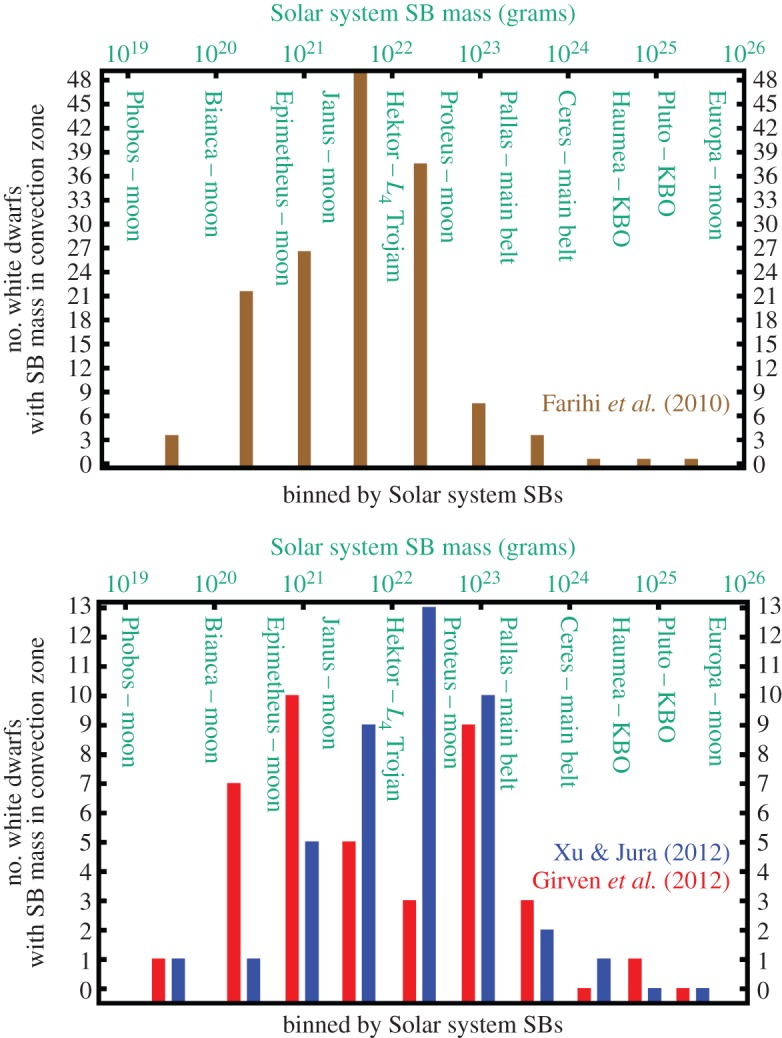
Histograms of the accumulated mass of rocky substellar bodies that were accreted onto white dwarfs during the last Myr or so, including both detections and limiting values. Differently coloured bars refer to three different WD samples (brown: data from [93] assuming that Ca represents 1.6% of the mass of the accreted bodies, similar to the corresponding mass fraction of the bulk Earth—see table 3 of [102]; blue: data displayed in fig. 12 of [103]; red: data displayed in fig. 9 of [104]). The panels are separated according to sample size (see y-axis). For observational subtleties associated with the data, see the corresponding papers. The bin sizes are according to the Solar system objects displayed in green, with masses given on the top axis. This plot demonstrates that pollution may arise from a wide variety of objects.